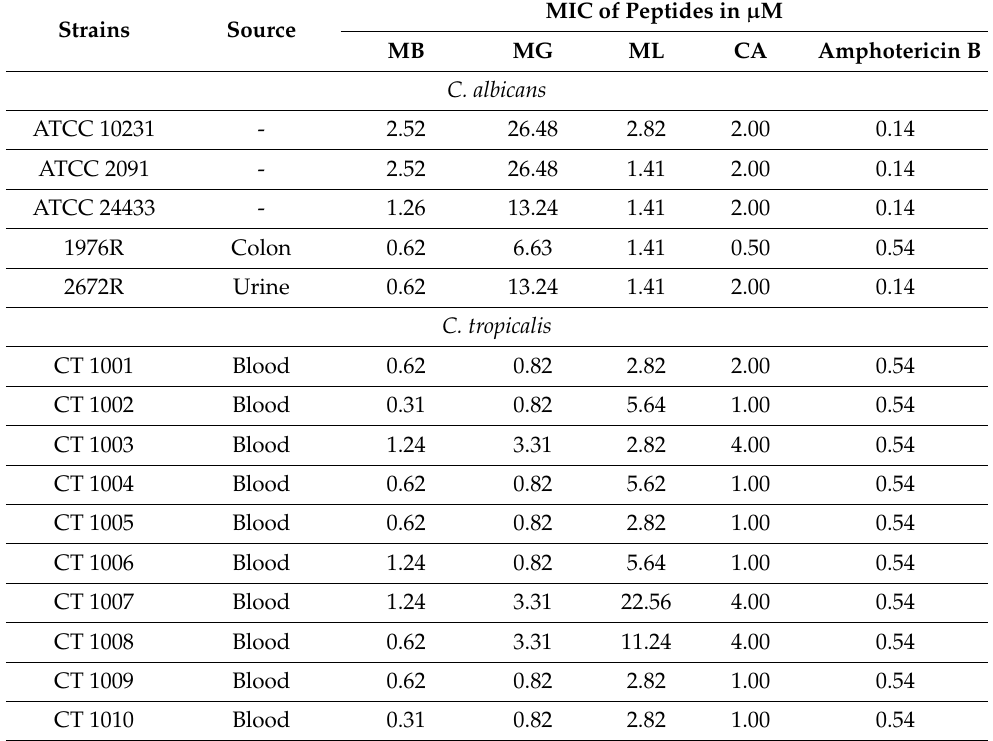
Table 2. MICs of pore-forming peptides against various “ Candida spp.” strains. NA